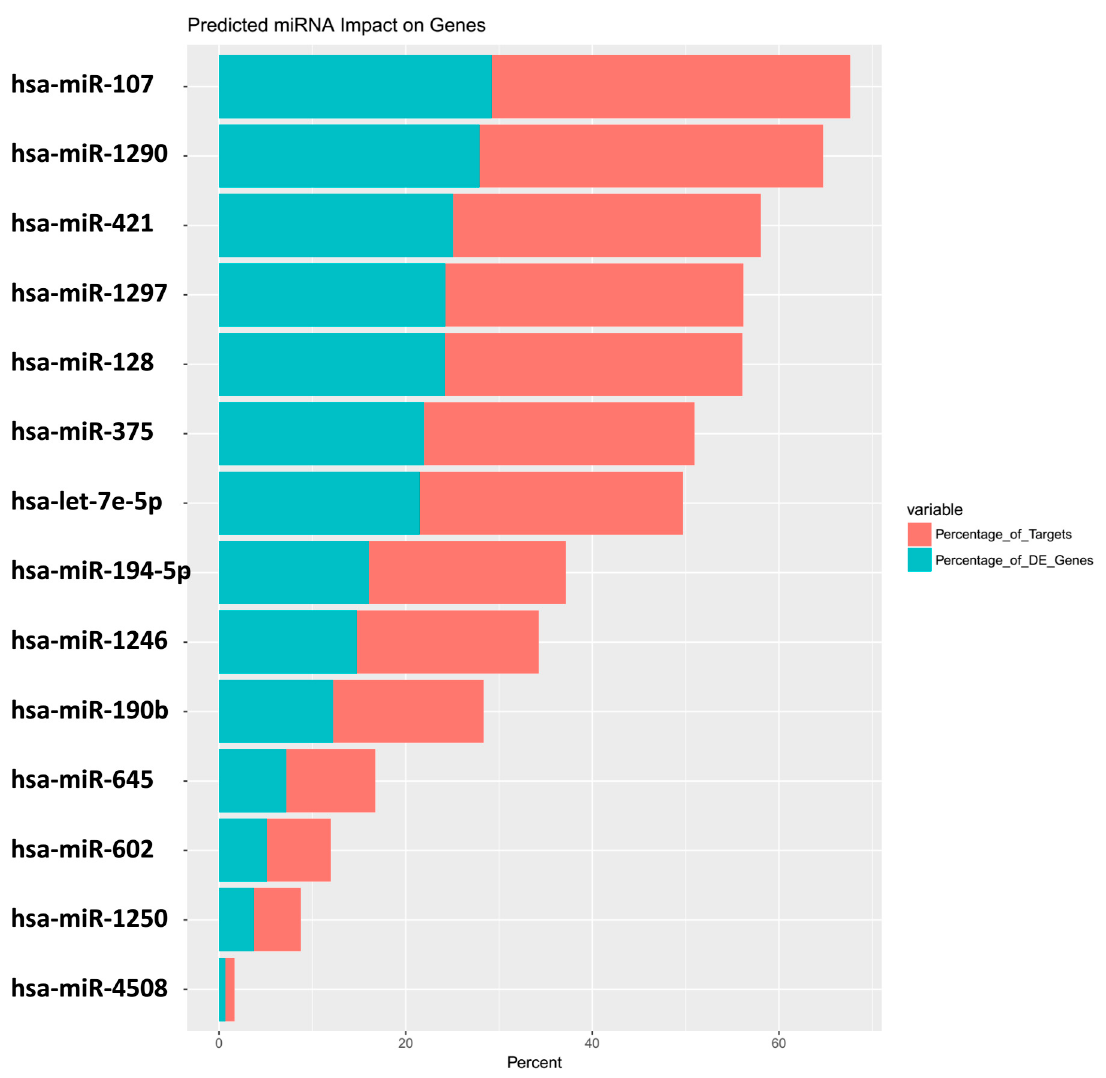
Figure 3. miRmapper output: miRNA boxplot. Data are presented in the order of the greatest number of impacted genes to the lowest, with the percentage of total targets affected by the miRNA in red and the percentage of total DE genes affected by the miRNA in blue.